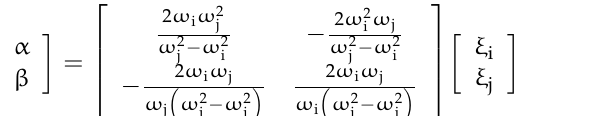
Table 1. Material and geometric properties used in simulation research. Parameter Symbol Unit Value Young modulus of PCB FR-4 substrate [36] Y s Pa 18.6 × 10 9 Young modulus of MFC patch [23] Y MFC Pa 30.336 × 10 9 Young modulus of passive area of MFC patch [10] Y MFCp Pa 2.9 × 10 9 Density of PCB FR-4 substrate ρ s kg/m 3 1900 Density of active area of MFC patch [15] ρ MFCa kg/m 3 5400 Density of passive area of MFC patch [11] ρ MFCp kg/m 3 1420 Elastic compliance of MFC patch [11] s E 33 m 2 /N 18.8 × 10 − 12 Piezoelectric charge constant of MFC patch [10] d 33 C/N 436 × 10 − 12 Thickness of piezoelectric fibers in MFC patch [7] t p mm 0.18 Distance between electrodes in MFC patch [7] t de mm 0.5